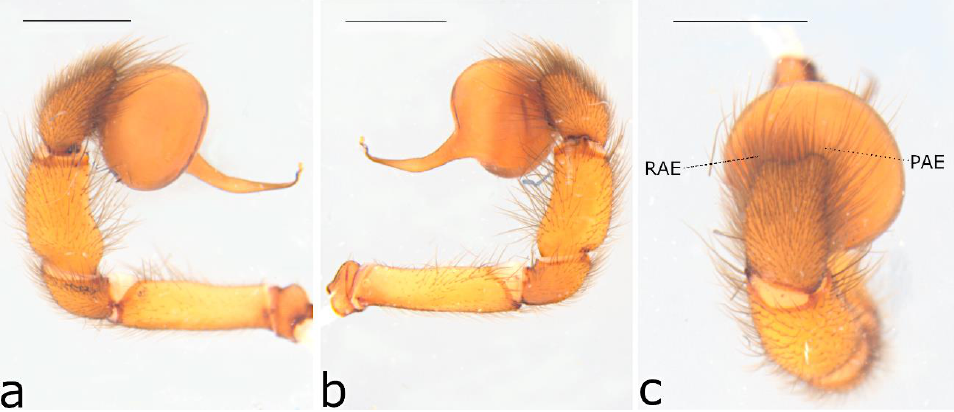
Figure 32. Ariadna curvata sp. nov. ♂ holotype (SAMA NN30589) from Arkaroola (SA): ( a ) left ped- ipalp, prolateral view; ( b ) same, retrolateral view; ( c ) same, cymbium. Scale bar = 1